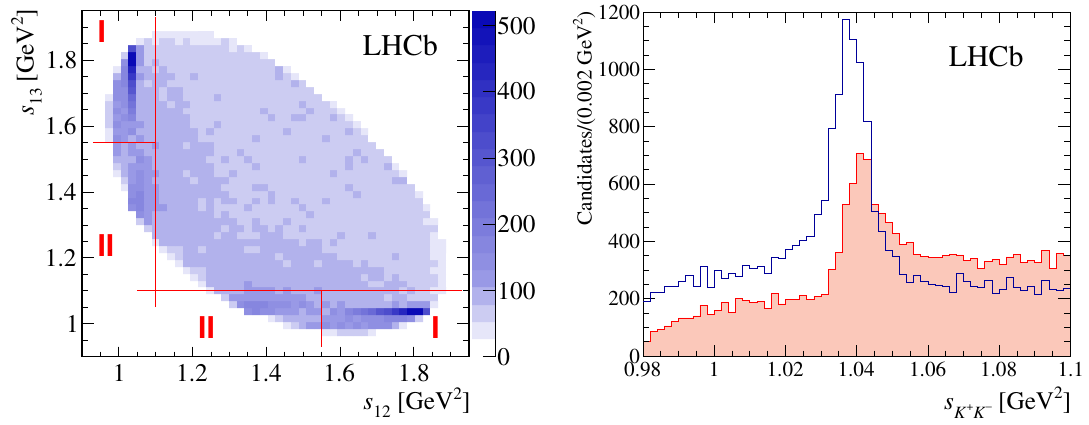
Figure 2 . (left) Dalitz plot of the selected sample, including background. (right) Dalitz plot projections for candidates from regions I (blue) and II (red), above and below s The interference between the S- and P-wave amplitudes cause the asymmetry in the number of candidates in the two regions, as well as the shift in the peak position. Both (cid:12)gures include all candidates in the selected mass